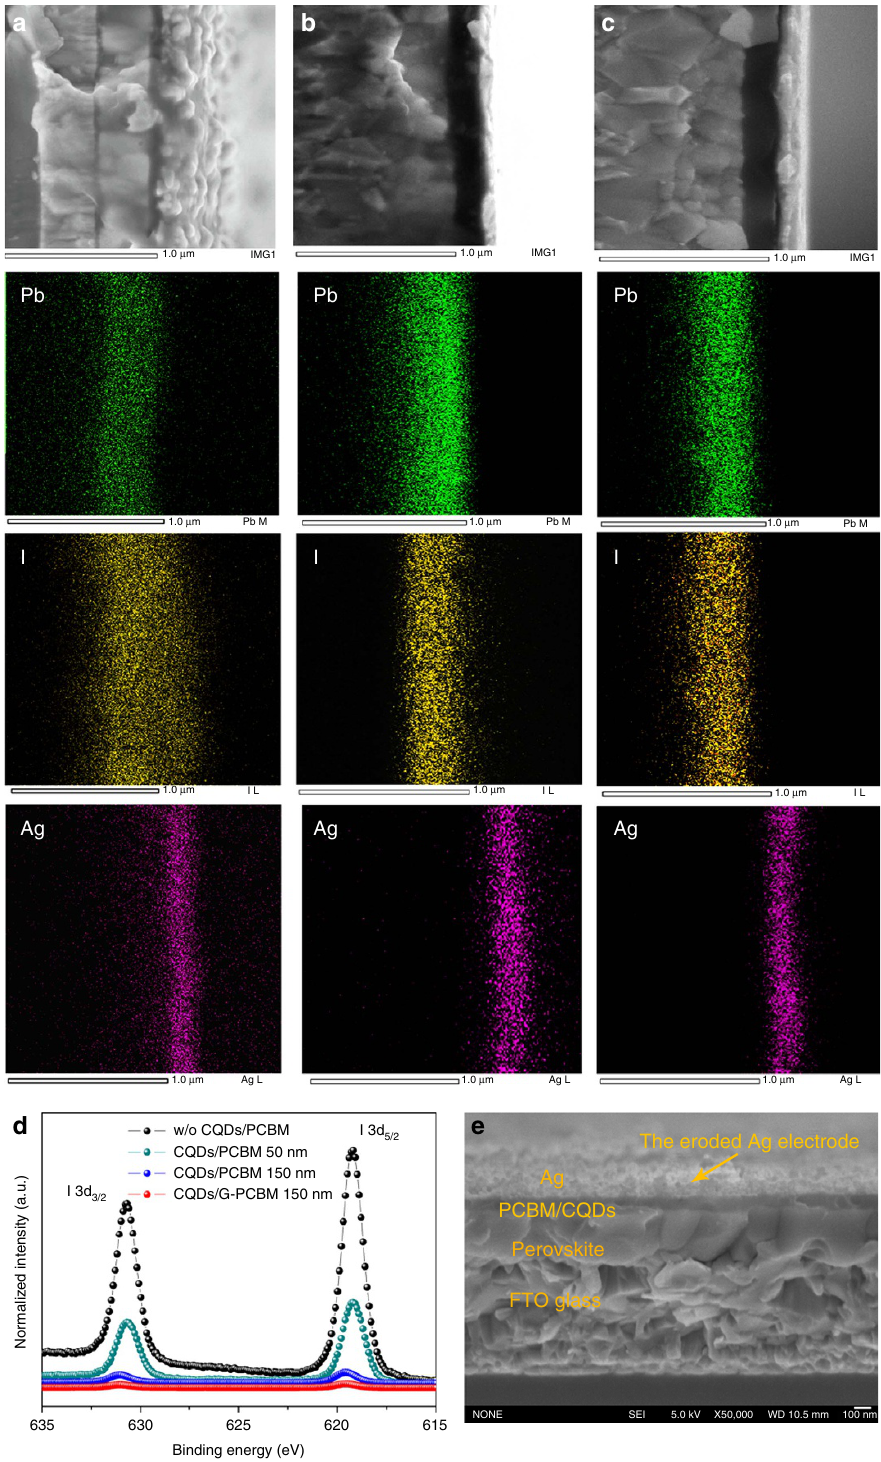
Figure 2 | Monitoring iodide distribution in PSCs. ( a – c ) SEM-EDX analysis of PSCs based on CQDs/fullerene derivative phenyl-C61-butyric acid methyl ester (PCBM) (50nm), CQDs/PCBM (150nm) and CQDs/N-doped graphene fullerene G-PCBM (150nm), respectively. The PSCs were preheated at temperature of 100 (cid:2) C in the dark and dry conditions for 90h. ( d ) XPS spectra of iodide at silver electrode. ( e ) SEM image of cross-section of PCBM (50nm) based device after thermal aging in the ambient environment for 7